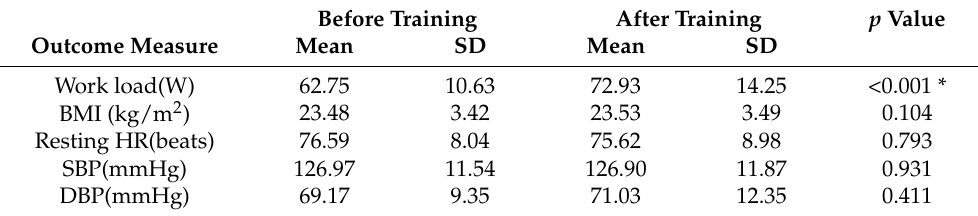
Table 4. The physiological parameters before and after 4 weeks cycling wheelchair